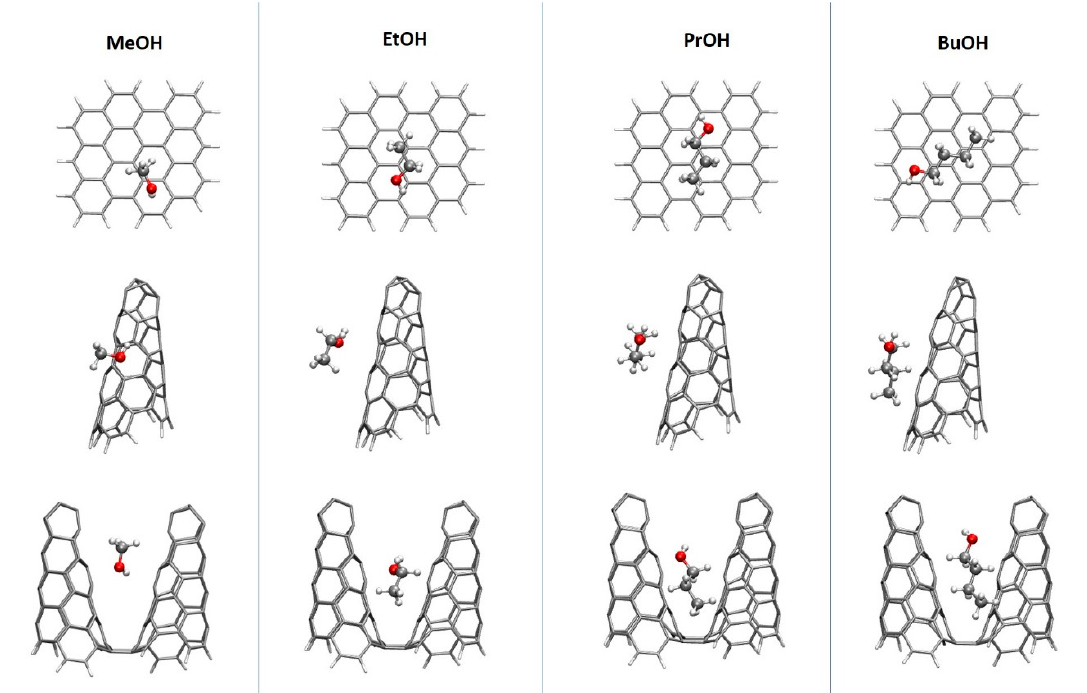
Figure 6. The most stable complexes of studied alcohols on: a graphene sheet and on SWCNH ( ω B97X-D/6-31G(d,p)). The exemplary complexes have been selected from the four of the initial